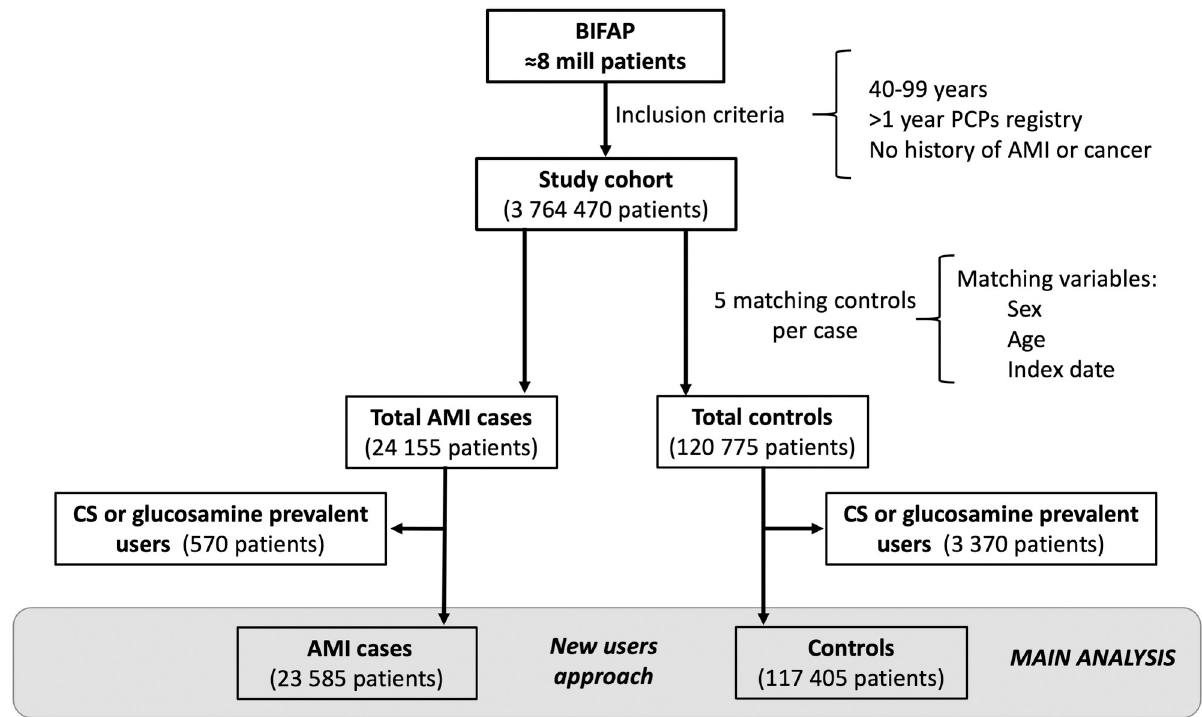
Fig 1. Flowchart of patient selection. Abbreviations: BIFAP:” Base de datos para la Investigacio´n Farmacoepidemiolo´gica en Atencio´n Primaria”; AMI: Acute Myocardial Infarction; CS: Chondroitin Sulfate.